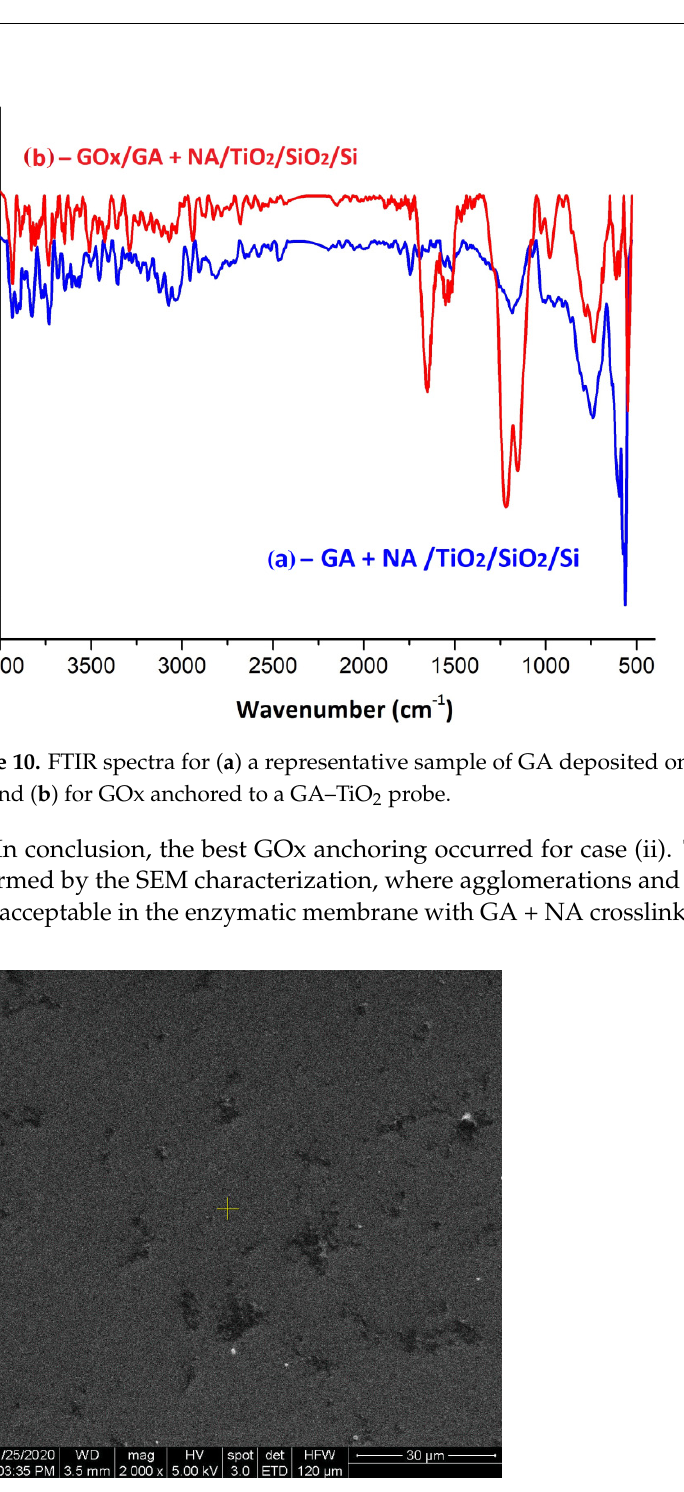
Figure 11. SEM image of the enzymatic membrane with GOx/(GA + NA)/TiO 2 /SiO 2 /Si from case